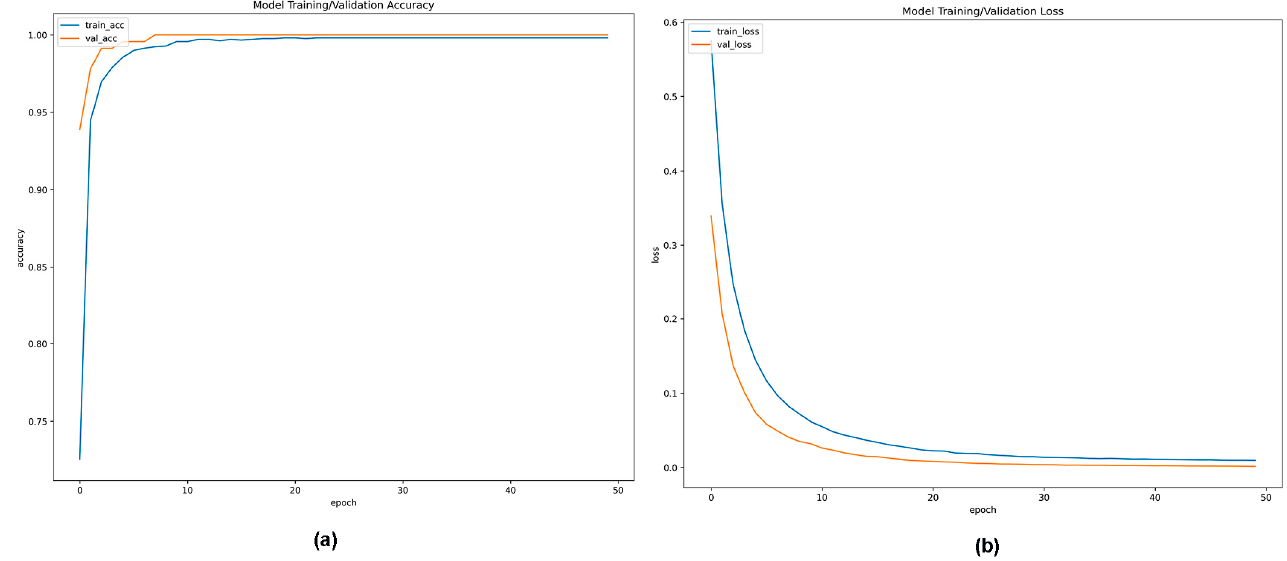
Figure 9. ( a , b ). ( a ) Training and validation accuracy convergence curve of ResNet50v2 model up to 50 epochs with an optimized learning rate of 0.00625; ( b ) Training and validation loss